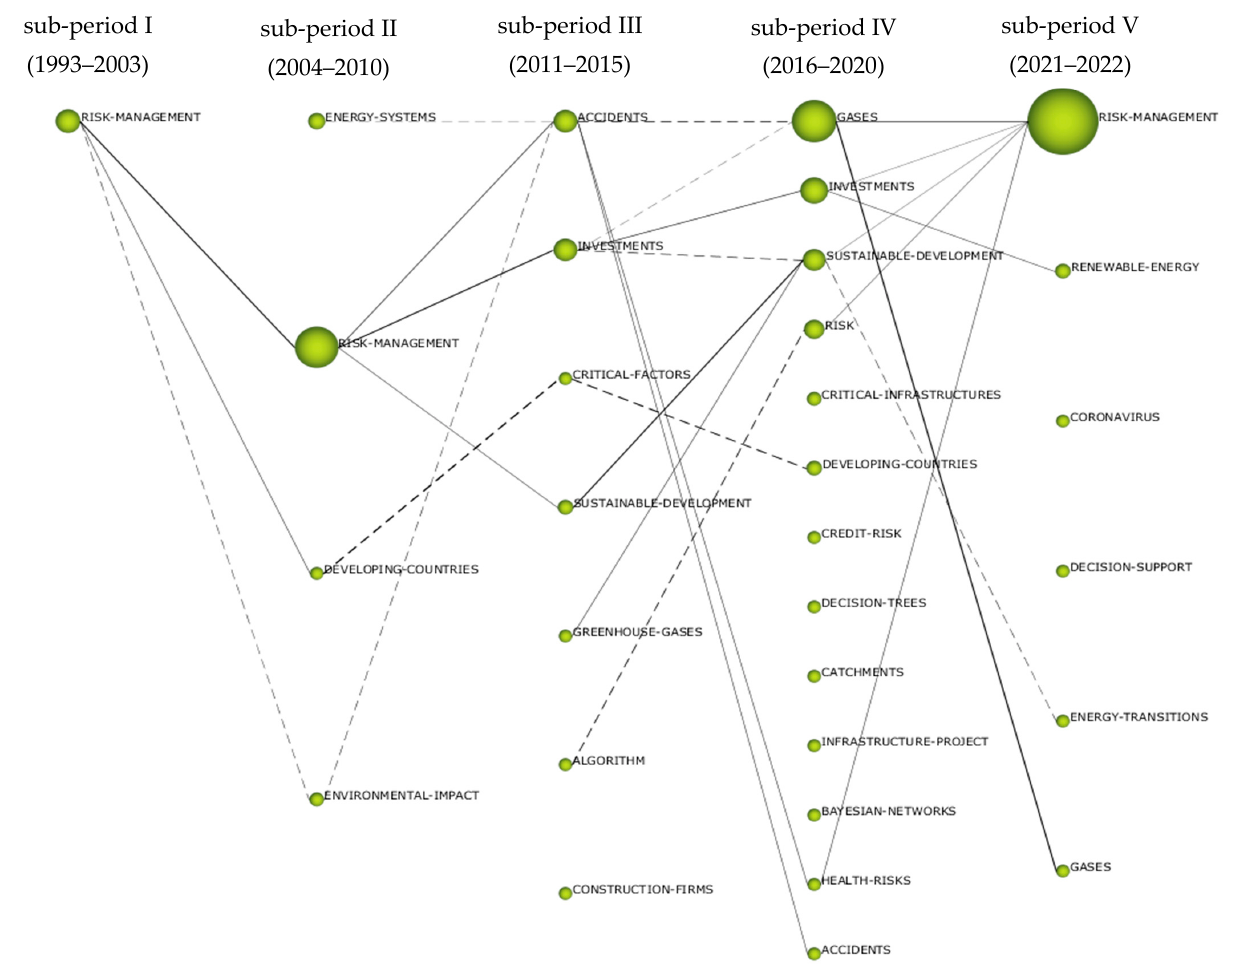
Figure 11. The thematic evolution of the field.